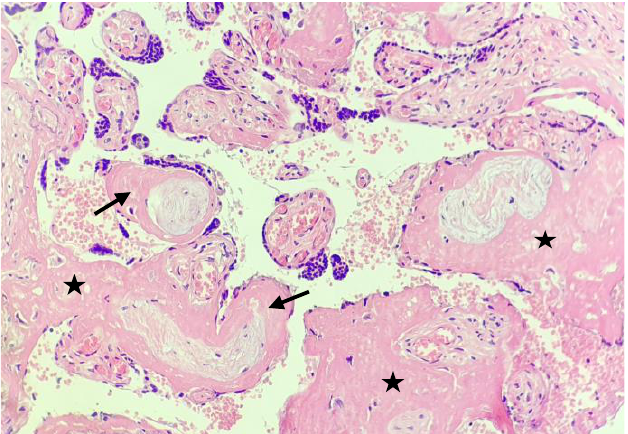
Figure 3. Detailed image showing marked peri-villous (star) and intra-villous (black arrow) fibrin deposition with dystrophy and ischaemic changes (20×).